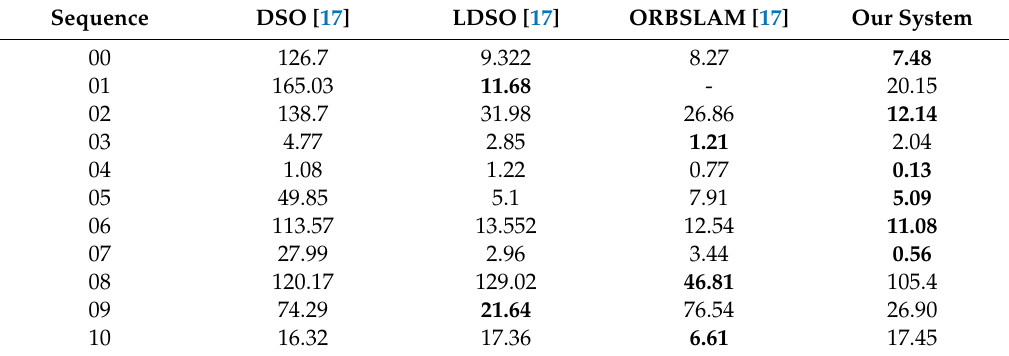
Table 1. The absolute trajectory errors (ATE) of our system, DSO, LDSO and ORB-SLAM on KITTI.